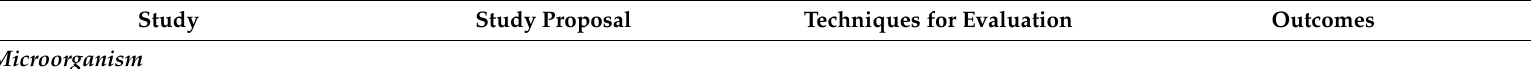
Table 4. The proposal, evaluation, and outcome of the CGG microfluidic device studies applied in toxicity